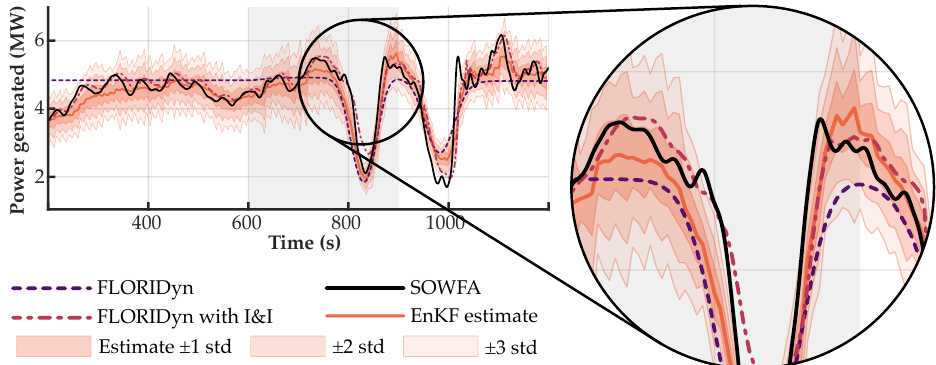
Figure 14. Comparison of the power generated by T1 in different FLORIDyn implementations. The gray area indicates the time window during which the wind direction